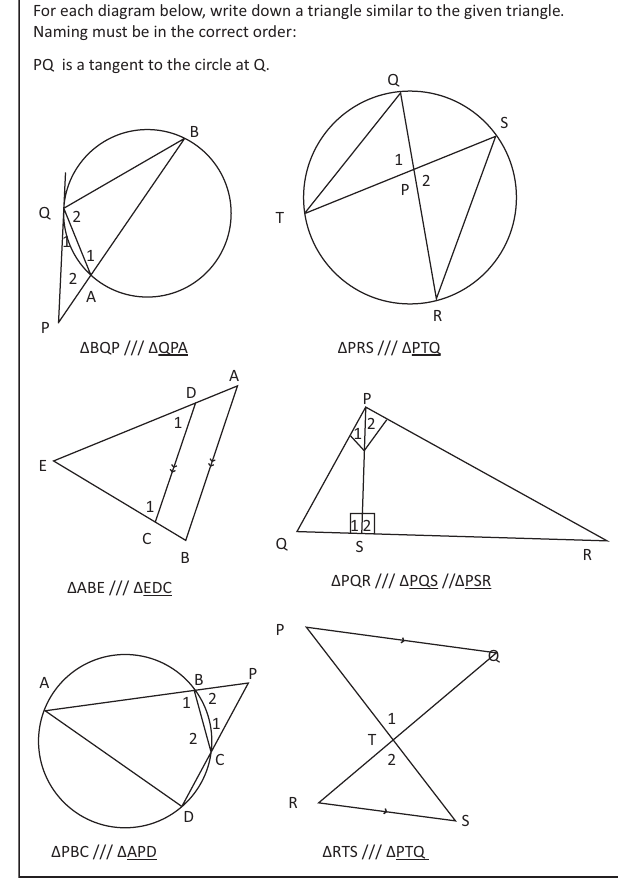
FIGURE 3: A representation of Sabelo’s response. FIGURE 2: Details of the